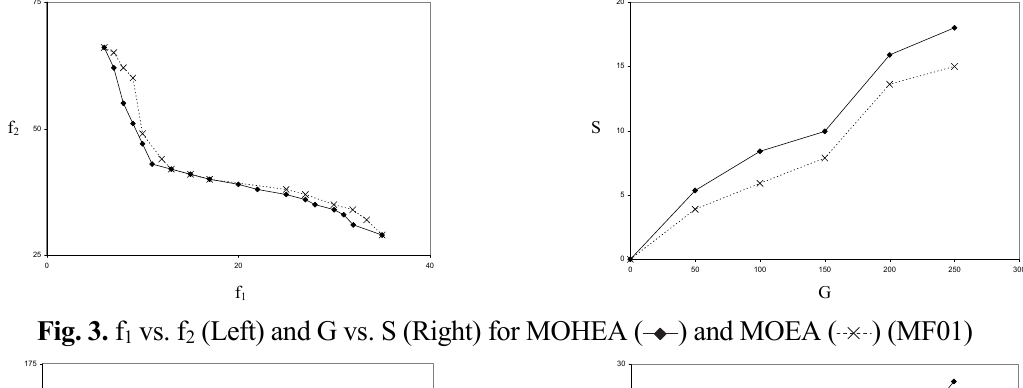
Fig. 3. f 1 vs. f 2 (Left) and G vs. S (Right) for MOHEA ( ) and MOEA (